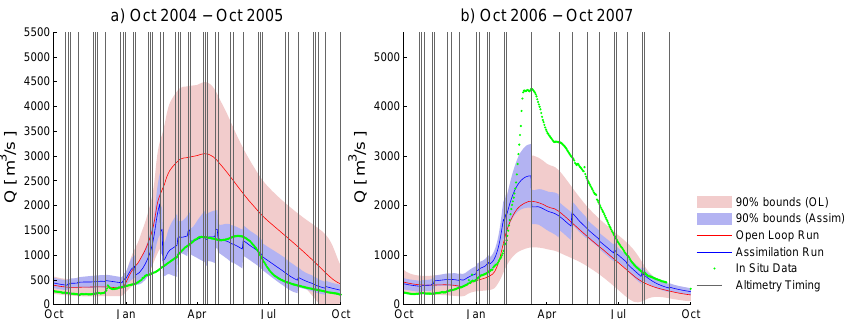
Fig. 4. Timing of altimetry measurements in watershed 1 and assimilation performance at reach 34 from October 2004 to October 2005 (a) and October 2006 to October 2007 (b) .